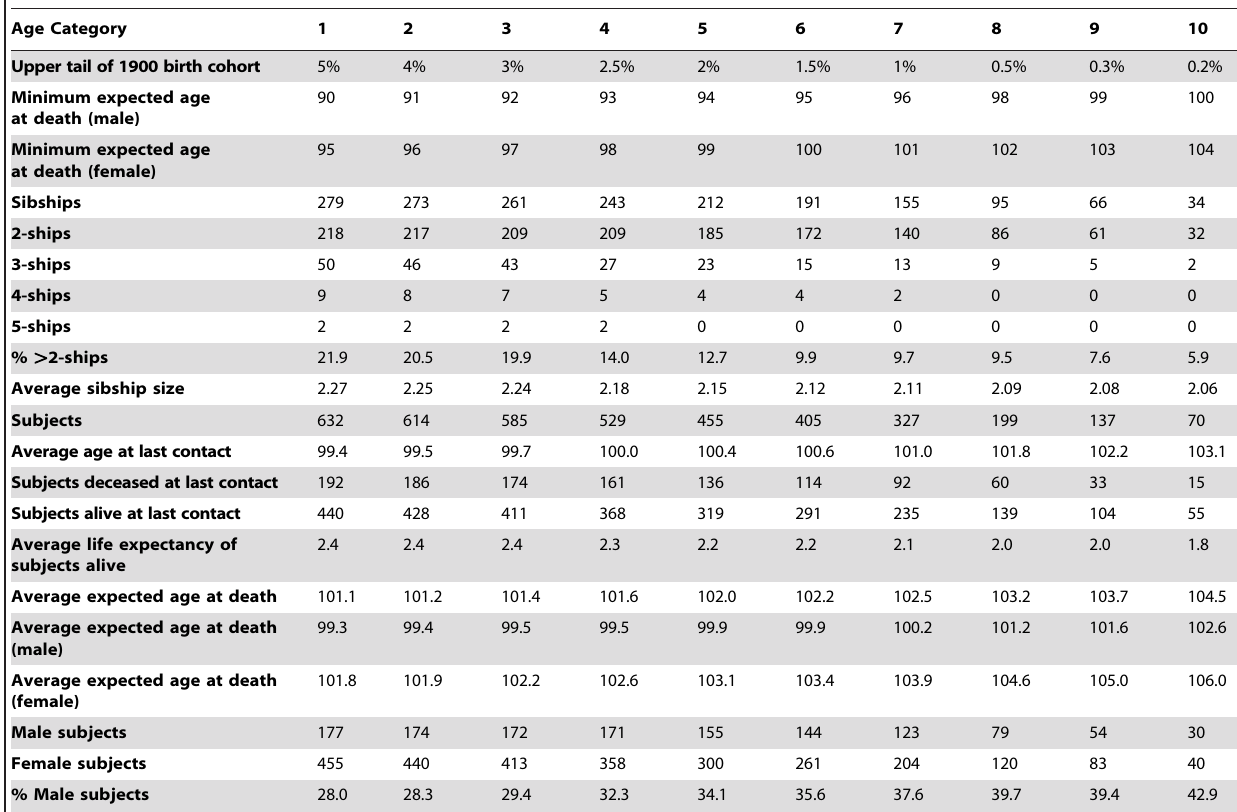
Table 1. Subject characteristics by age category for Total